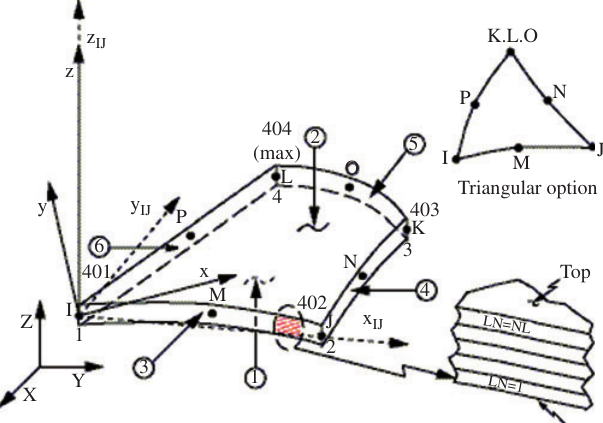
Figure 3 SHELL91 geometry [18] .